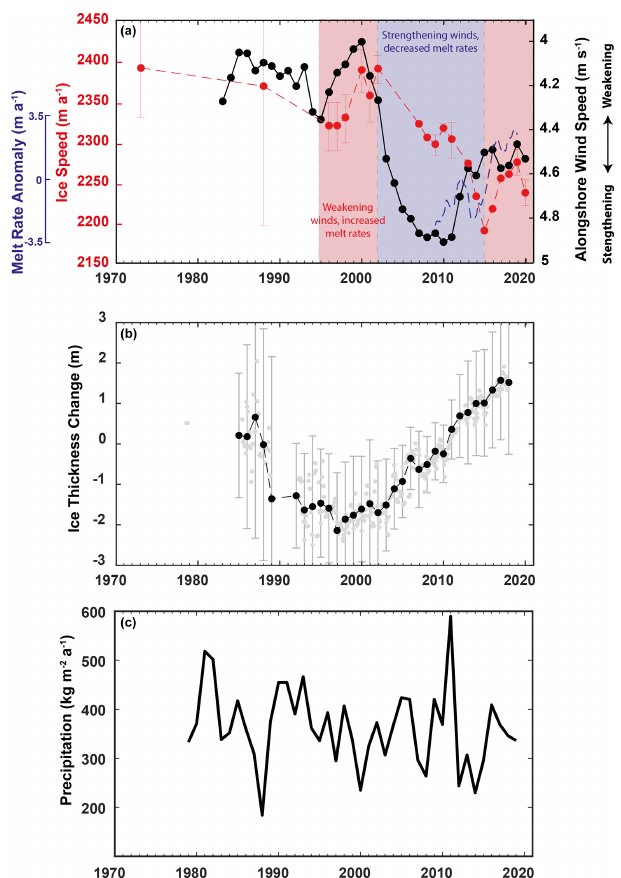
Figure 3. (a) Annually averaged ERA5-derived alongshore wind speed from Box A (see Fig. 1) and plotted as a 5-year rolling mean (black), ice speed at the Shirase Glacier grounding line along T1 (red) and modelled melt rate anomaly of the Shirase ice tongue be- tween 2008 and 2018 plotted as a 1-year rolling mean (blue; Kusa- hara et al., 2021a). Periods of weakening winds cause increased mCDW transport, increased basal melt and acceleration. Periods of strengthening winds result in relatively less mCDW transport, decreased basal melt rates and glacier slowdown. Note that along- shore wind speed is plotted with an inverted axis. (b) Annually av- eraged ice thickness change at point IT with respect to 2009/10 (see Fig. 2a) extracted from the Schröder et al. (2019) dataset, where there are at least six data points in the calendar year. The error bars are annually averaged errors. The background grey points are the raw monthly data points. (c) Annually averaged precipitation over Shirase Glacier from the MAR regional climate model (Kittel et al., 2021); uncertainties are not provided with these data.